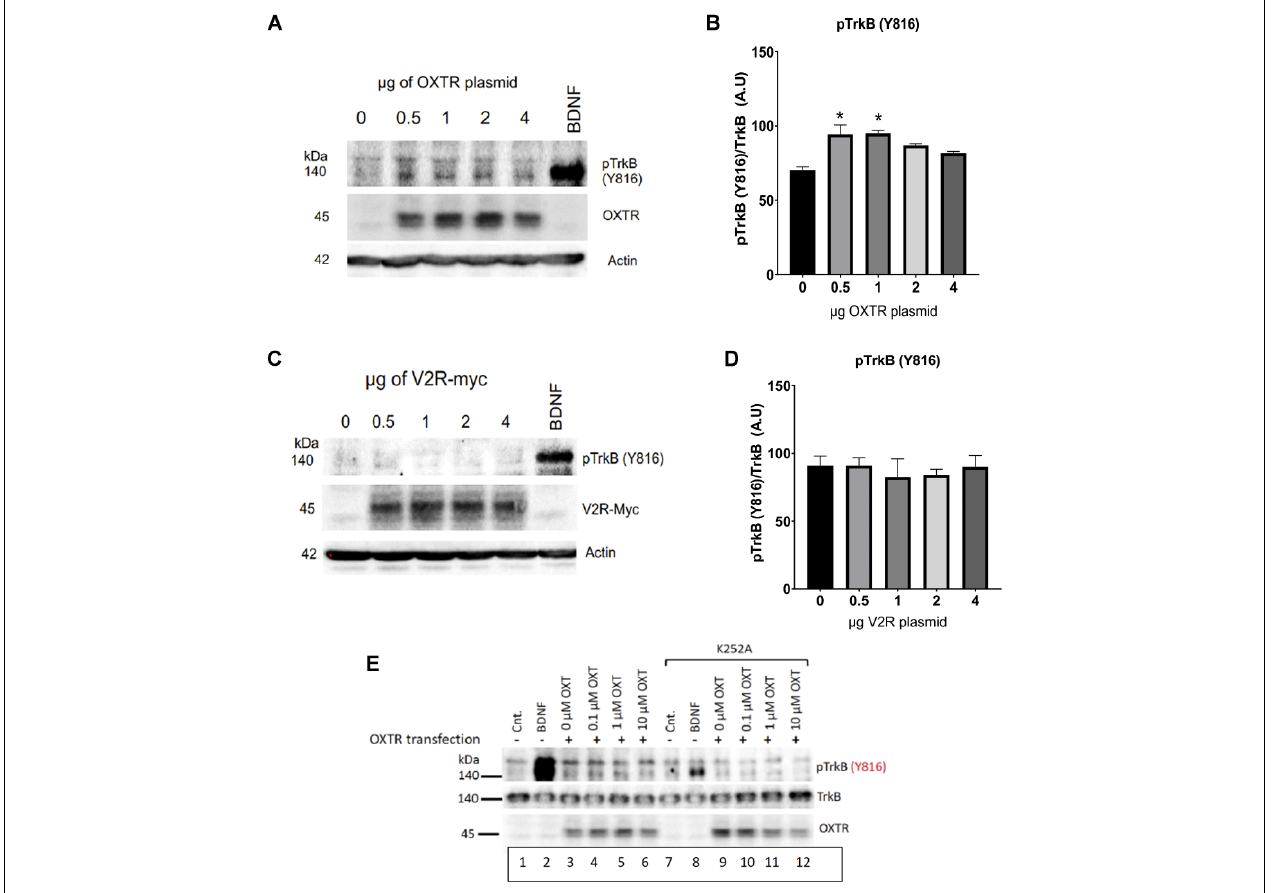
FIGURE 5 | Oxytocin receptor (OXTR), but not vasopressin receptors (V2R), induces TrkB phosphorylation. HEK-293-TrkB cells were transfected with increasing amounts of OXTR (A) and V2R (B) plasmids for 16 h and then the levels of pTrkB-Y816 (Cell Signaling 4168) were detected by Western blot. BDNF treatment was used as a control. Quantitation of pTrkB from increasing plasmid amounts is shown plots (C,D) . All p values were determined with ANOVA test followed by post-hoc Tukey (* p < 0.05). (E) Treatment with K252a. The Trk inhibitor, K252a (Berg et al., 1992) at a concentration of 200 nM blocks BDNF and oxytocin-mediated transactivation of TrkB receptors. Lanes 2 and 8, BDNF treatment. Lanes 3-6 and 9-12, Transfection of OXTR. Lanes 7-12, Treatment with K252a. HEK293-TrkB cells are transfected with oxytocin receptor (OXTR) and monitored for expression by western blot. Controls (Cnt) are untreated cells, lanes 1 and 7. OXT, oxytocin